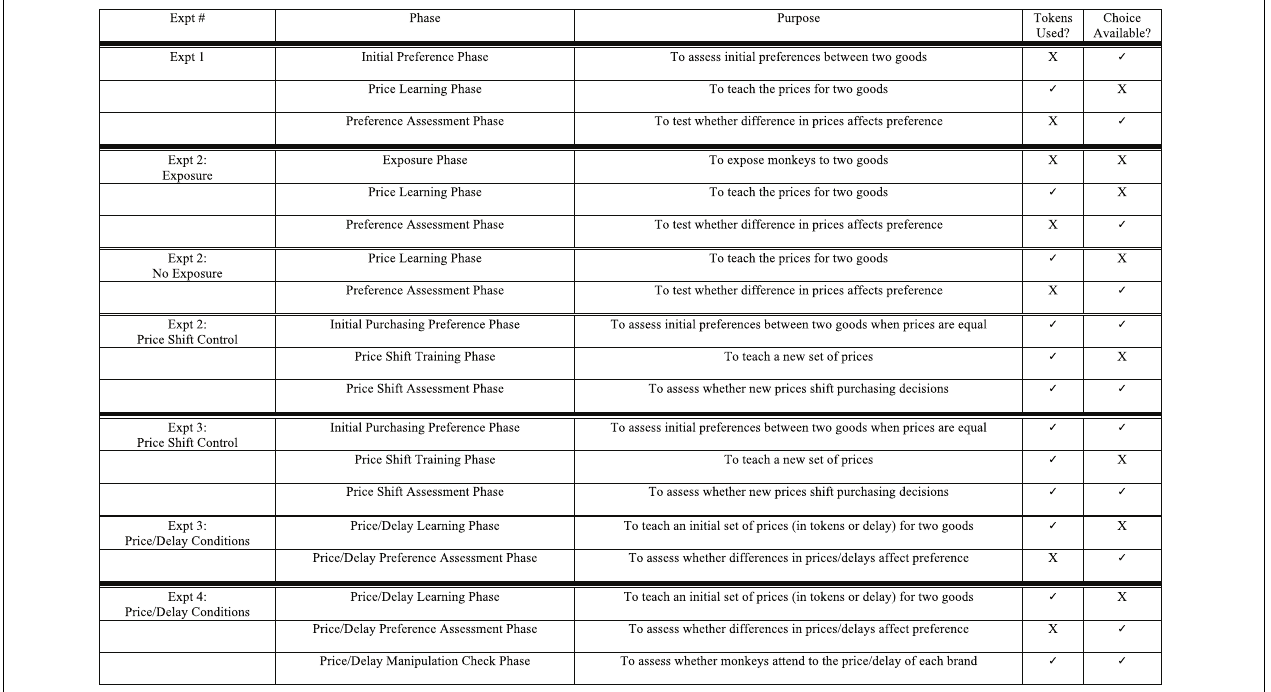
FIGURE 1 | Description of different experimental conditions and